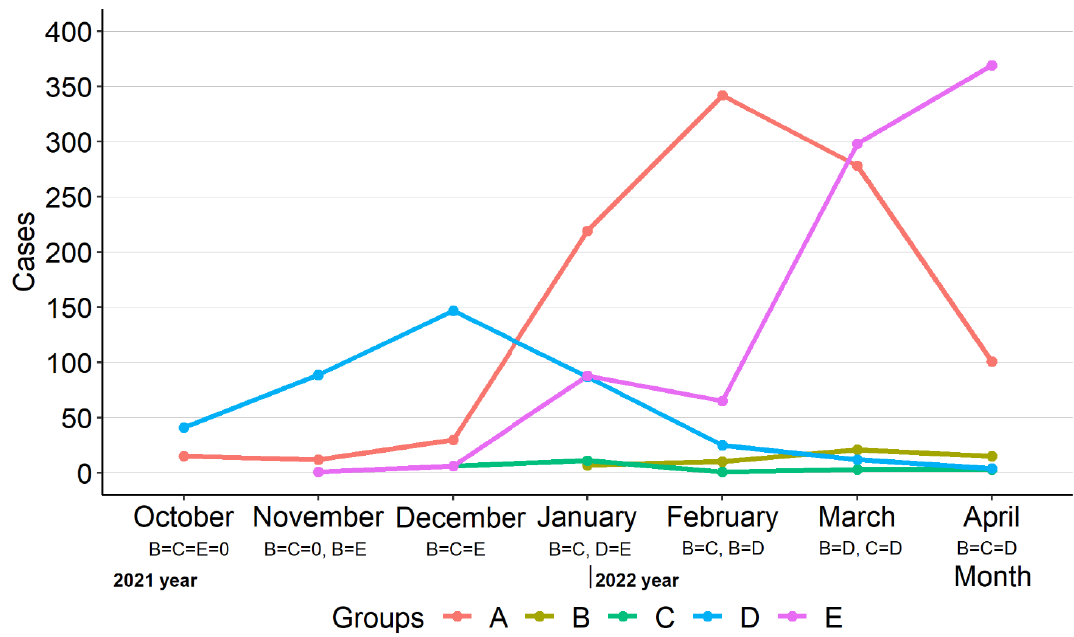
Figure 3. Distribution of cases (Groups A–E) monthly. Group A: SARS-CoV-2; Group B: SARS-CoV-2 and influenza A/B; Group C: SARS-CoV-2 and RSV; Group D: RSV; Group E: influenza A/B. The equality symbol indicates statistically insignificant differences between the proportions of the groups, and also indicates when the proportions of the groups being compared were zero, in which case the statistical test was not applied (B, C and E in October 2021, B and C in November 2021). The initial analyses carried out to determine the number of change points found that all segmented regression models have one change point. The best segmented regression fit was found in Group E with a change point at the fifth month (February 2022) (adjusted R-squared = 0.9098, change point estimate 5, 95% CI 3.2–6.8); Group D with a change point at the third month (December 2021) (adjusted R-squared = 0.7761, change point estimate 2.9, 95% CI 0.8–4.9); and Group A with a change point between the fifth and sixth month (February 2022 and March 2022) (adjusted R-squared = 0.7192, change point estimate 5.6, 95% CI 4.1–7.1). However, in Groups B and C, the 95% confidence intervals